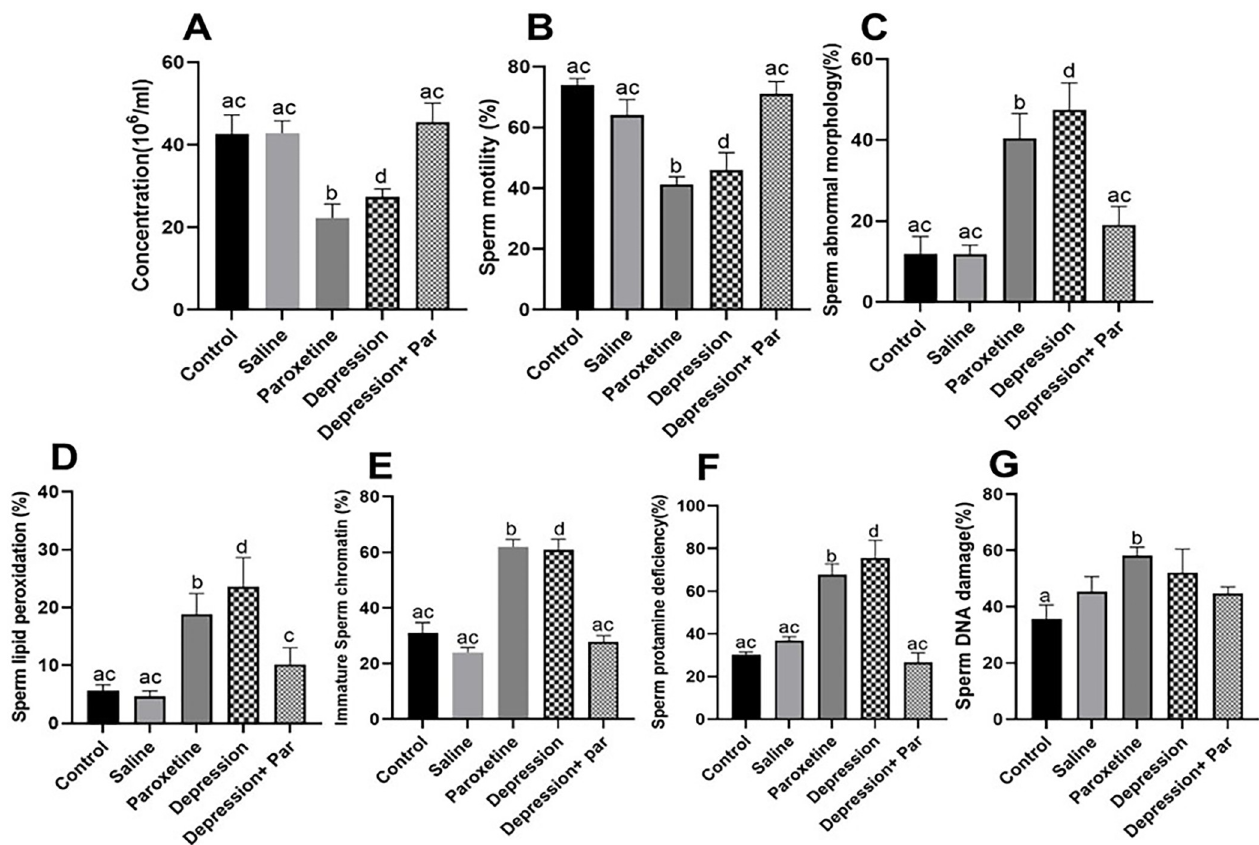
Fig 5. Comparison of mouse sperm parameters in the different groups (N=6 for each group). A : Concentration (in million /ml). B : Motile spermatozoa (in %). C: Spermatozoa with abnormal morphology (in %). D: Spermatozoa showing lipid peroxidation (in %). E: Spermatozoa having immature sperm chromatin (in %). F: Spermatozoa showing protamine deficiency (in %). G : Spermatozoa showing DNA damage (in %). Bars with different superscript letters are significantly different (p < 0.05). Par =